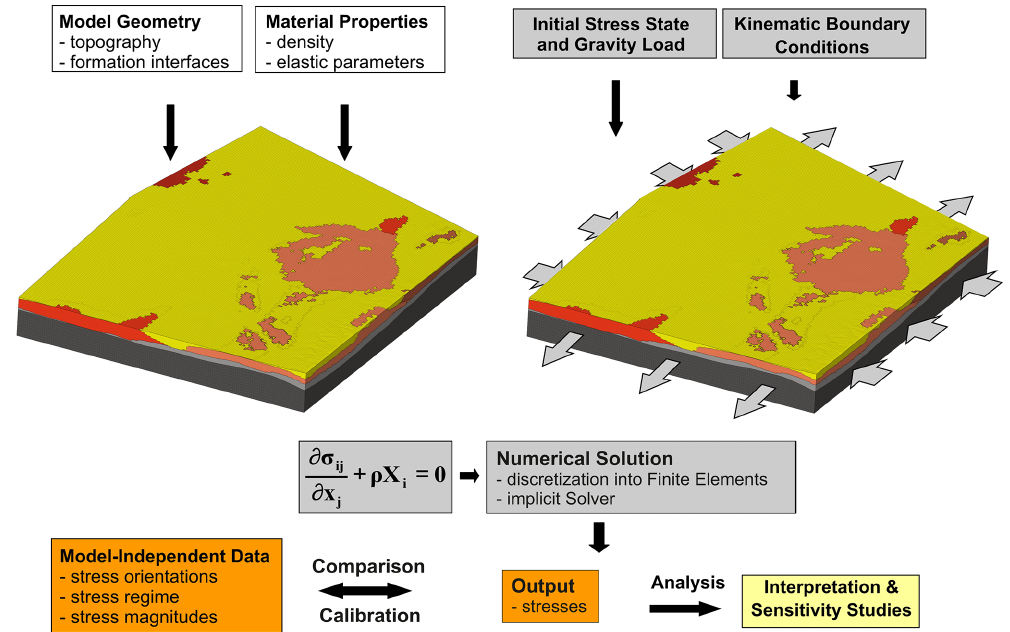
Figure 3. General workflow of 3D geomechanical–numerical modeling. White boxes: assembly of model geometry and rock properties. Left figure: 3D view of the discretized model volume. Grey boxes: initial stress field and kinematic boundary conditions, gravity load and numerical solution. An appropriate initial stress state and kinematic boundary conditions are determined and applied as well as gravity load. Right figure: discretized model volume including boundary conditions used. The partial differential equation of the equilibrium of forces in 3D is solved using the FEM ( σ ij stress tensor, x j Cartesian coordinates, ρ density, and X i body forces). Orange boxes: model results are calibrated against model-independent observations. Yellow box: once the fit to the model-independent observations is acceptable, i.e., within their uncertainties, an interpretation and analysis of the model results can be